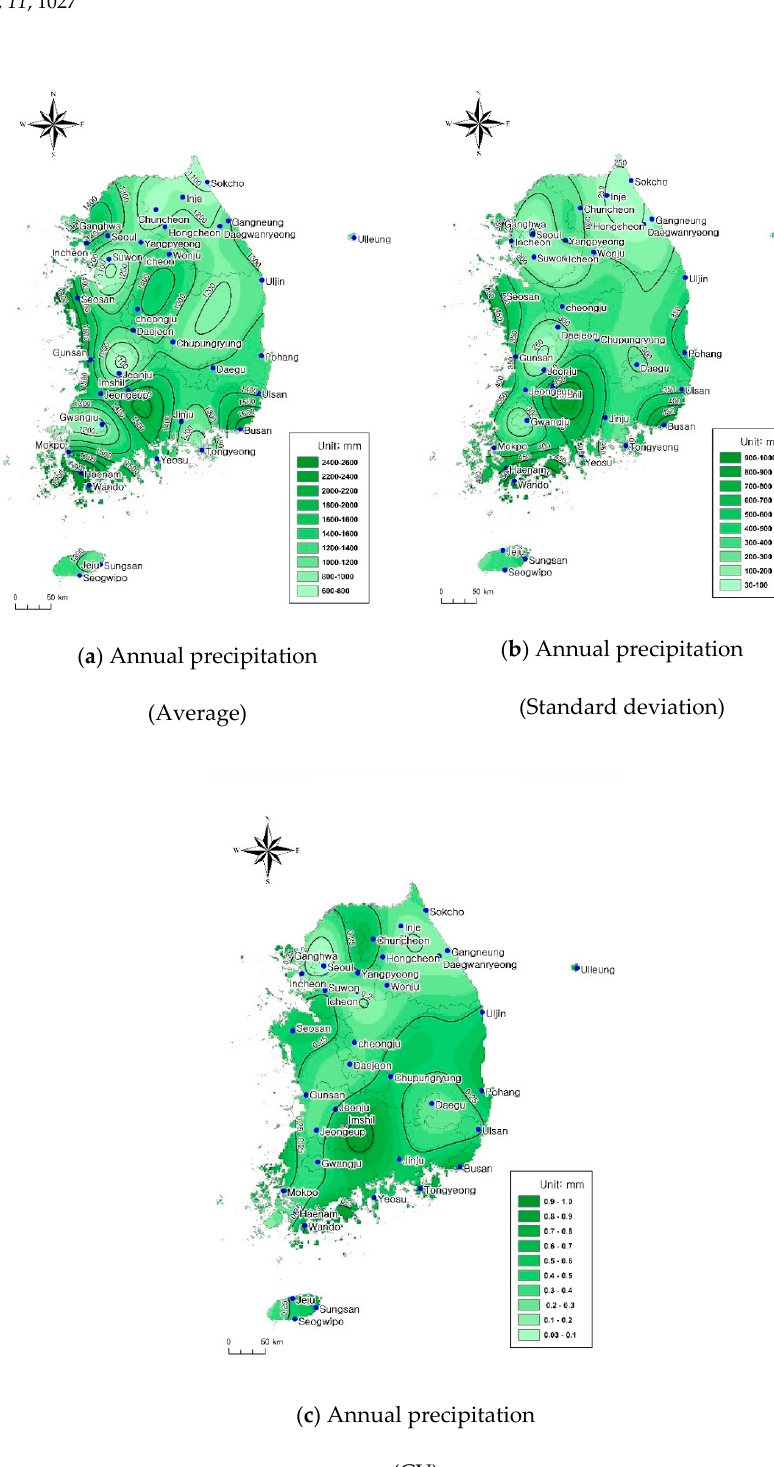
Figure 3. Average, coefficient of variation (CV), and standard deviation of the annual precipitation (mm) . ( a ) is the average of the annual precipitation, ( b ) is the standard deviation of the annual precipitation, and ( c ) is the CV value of the annual precipitation.